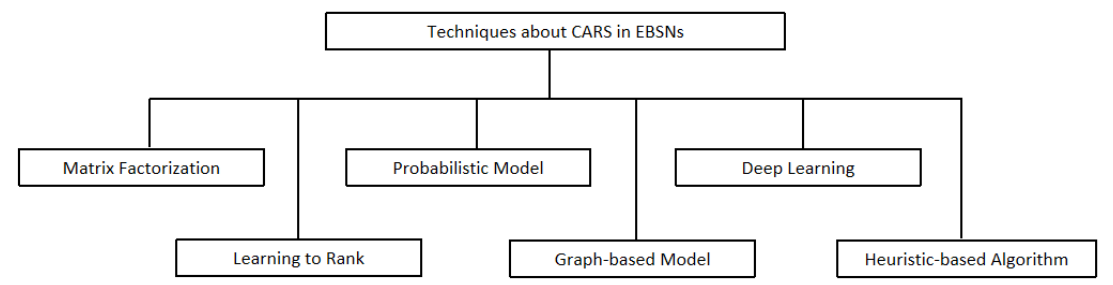
Figure 3. Layout of the techniques used in the